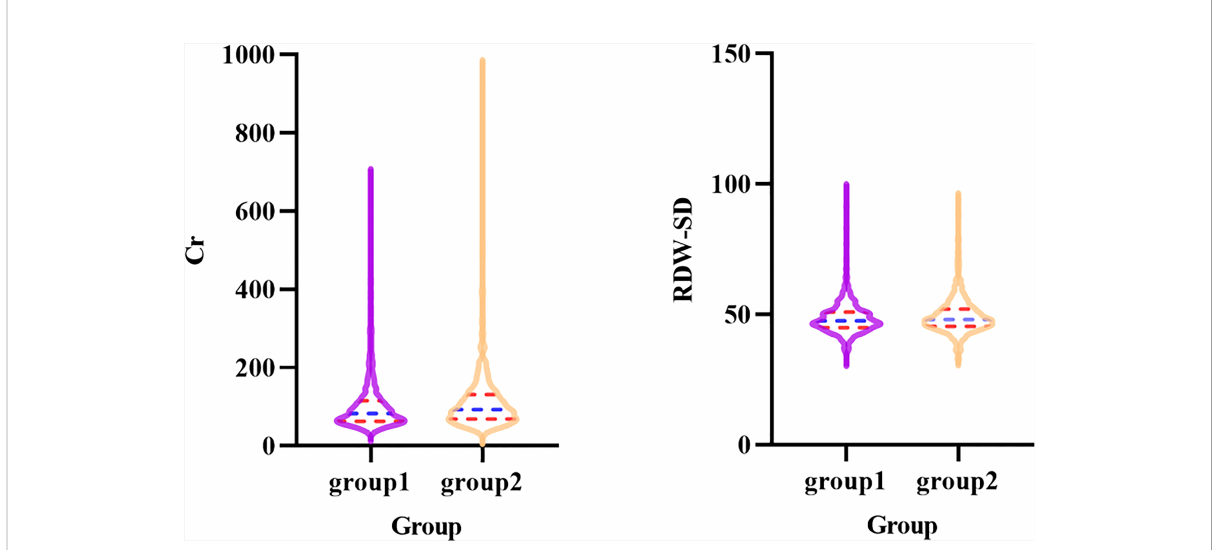
FIGURE 5 Violin plot of Cr and RDW-SD in patients with heart failure in readmission and non-readmission within 6 months groups (Group1: non- readmission; Group2: readmission).